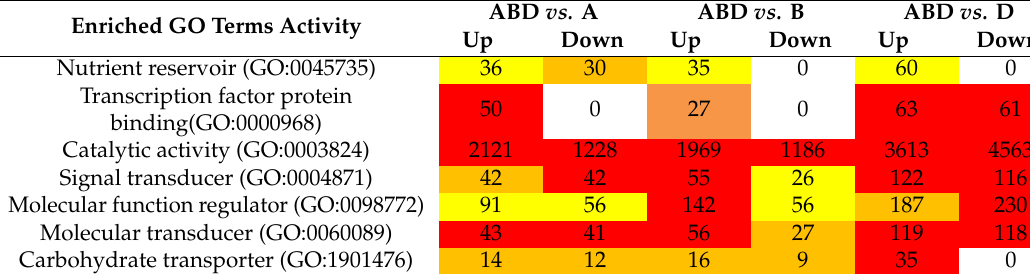
Table 5. Major GO term activities derived from DEGs comparing ABD vs. A, B, and D separately.